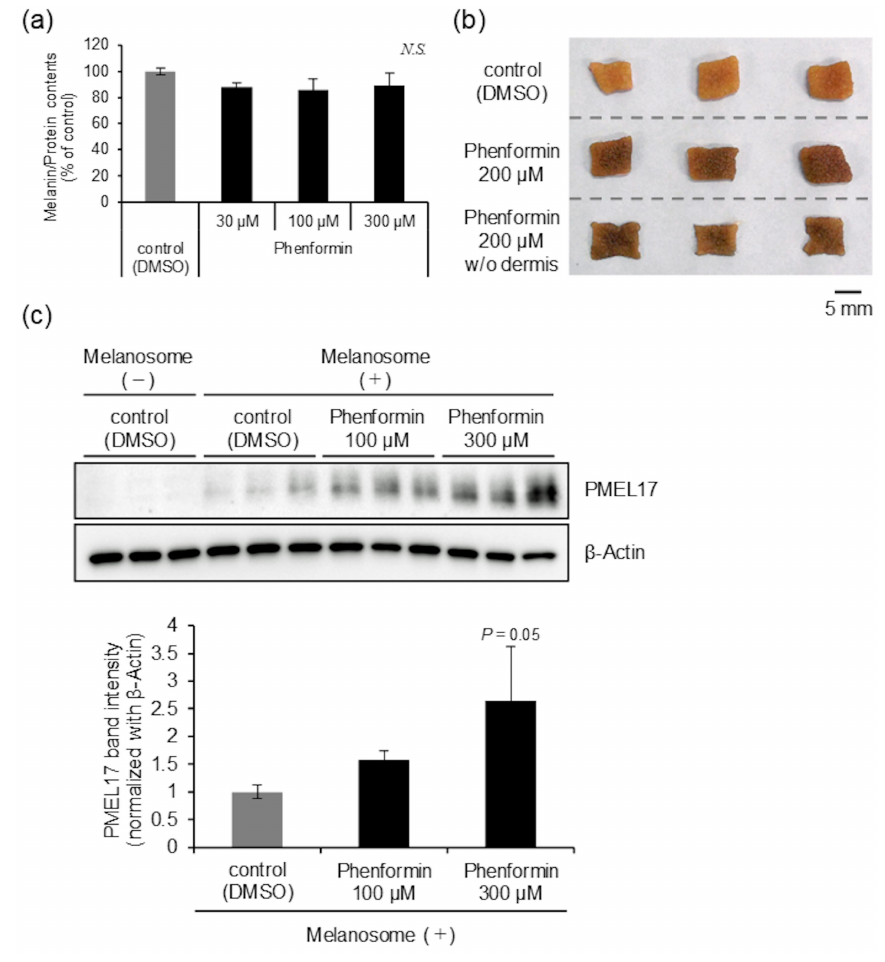
Figure 2. Phenformin decreases melanosome degradation in normal human epidermal keratinocytes (NHEKs). ( a ) Cellular melanin content of normal human epidermal melanocytes (NHEMs) treated with or without phenformin for 7 days (at the indicated concentrations). Values represent means